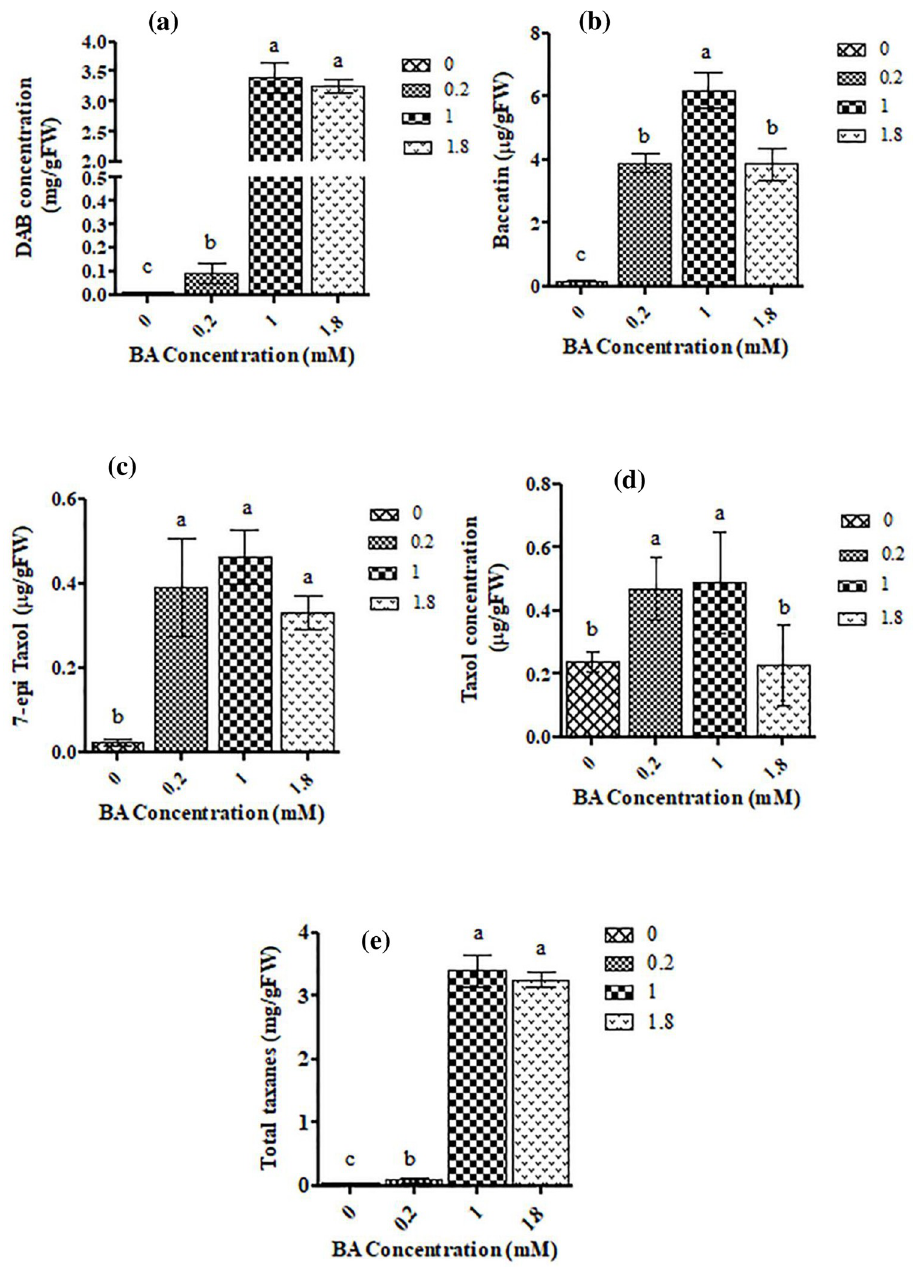
Fig 3. The content of DAB (a) , Baccatin (b) , 7- epi Paclitaxel (c) and Paclitaxel (d) in C . tarraconensis treated with various BA supply. Data are presented as mean ± SD, n = 3. Different letters show significant differences at P < 0.05 according to Duncan